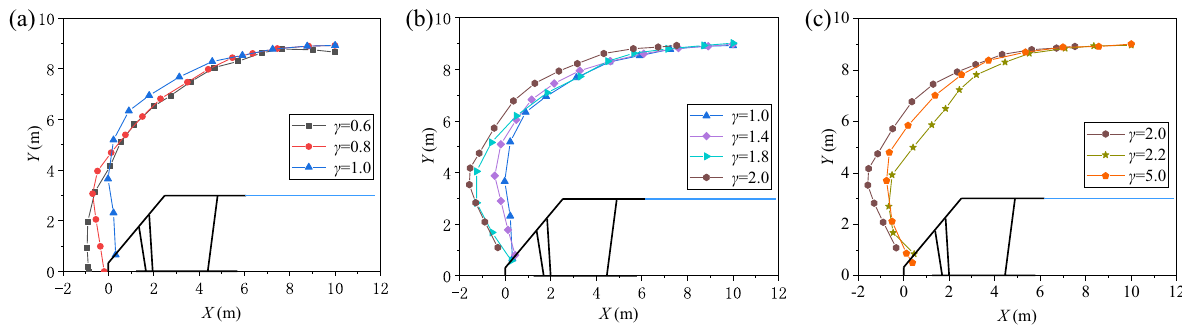
Fig. 25 Development of the final top-coal boundary: a 0.6 ≤ γ ≤ 1.0, b 1.0 ≤ γ ≤ 2.0, and c 2.0 ≤ γ ≤